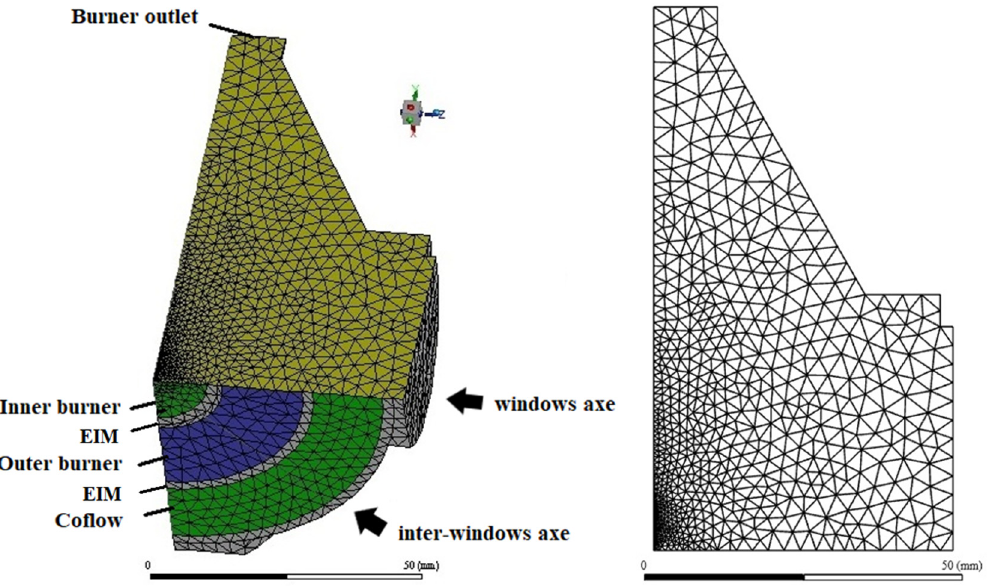
Figure 2. The 3D of mech domain and boundary conditions and the 2D section of the enclosed burner inner volume. inner